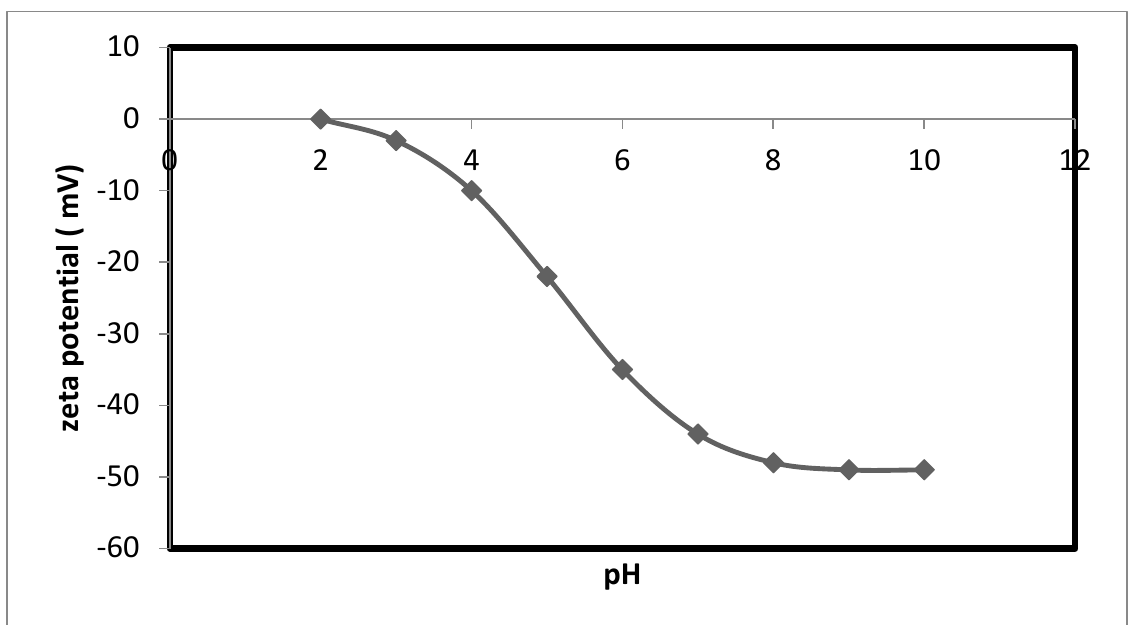
Figure 5. Variation of zeta potential versus pH for the nanocellulose.